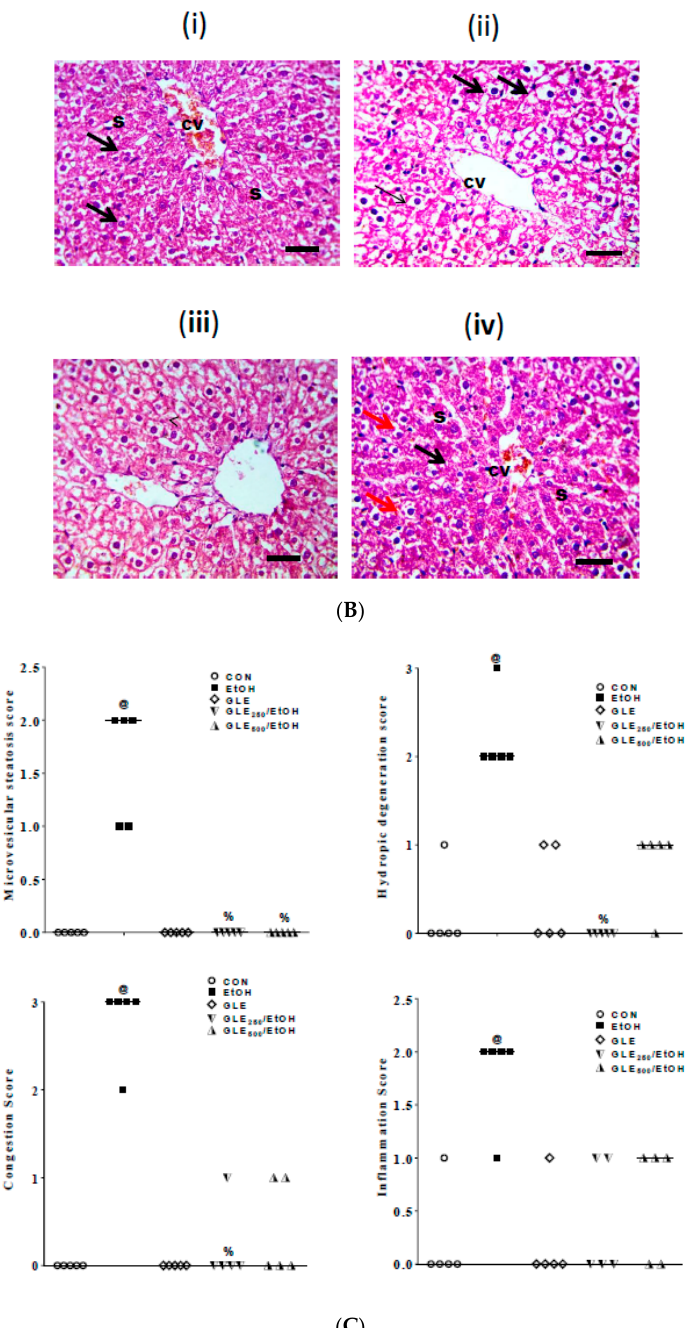
Figure 8. Effects of GLE on histopathological changes in liver sections in EtOH-treated rats. ( A ) Representative photomicrographs of liver sections stained with H&E from CON (i), EtOH (ii–iv), GLE 250 /EtOH (v) and GLE 500 /EtOH (vi) groups; ( B ) from CON (i), EtOH (ii), GLE 250 /EtOH (iii) and GLE 500 /EtOH (iv) groups; ( C ) Scatter-dot plot showing microvesicular steatosis, hydropic degeneration, congestion and inflammation Score. The data shown are the median (n = 5), @,% p ≤ 0.05 compared with Control, EtOH, group, respectively. Statistical analysis was performed using Kruskal–Wallis followed by Dunn’s Multiple Comparison test.